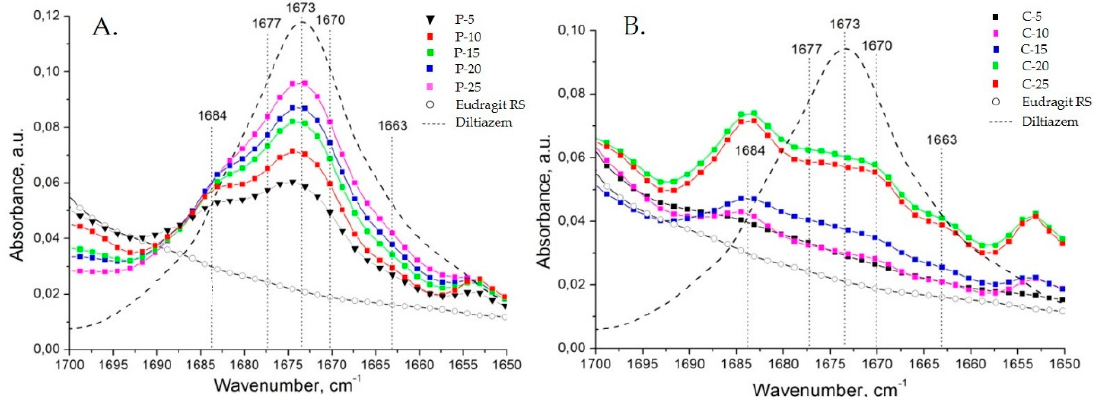
Figure 4 . Concentration-dependent changes in the infrared spectra of ( A ) physical diltiazem- Eudragit RS mixtures (P) and ( B ) solid diltiazem–Eudragit RS solutions (highly dispersed composites) (C)